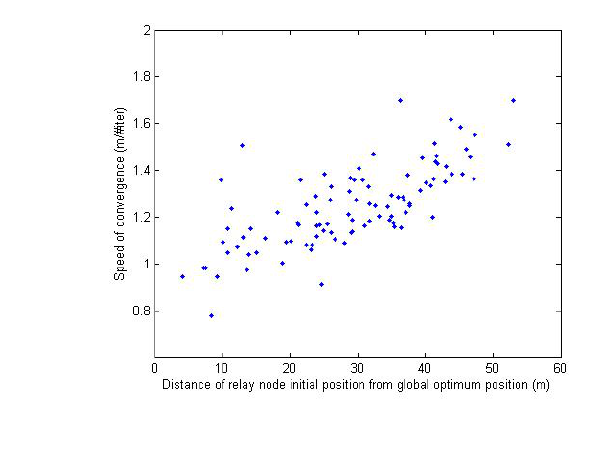
Figure 8. Case 1 simulation results for 100 trials with random relay node initial positions. ( a ) Relay node path from the initial position (red) to the optimum position (green). Blue dots indicate the server and client node locations. Theoretical optimum (*) is at the center (0,0); ( b ) Scatter plot of the distance of initial relay node position from the optimum against the speed of